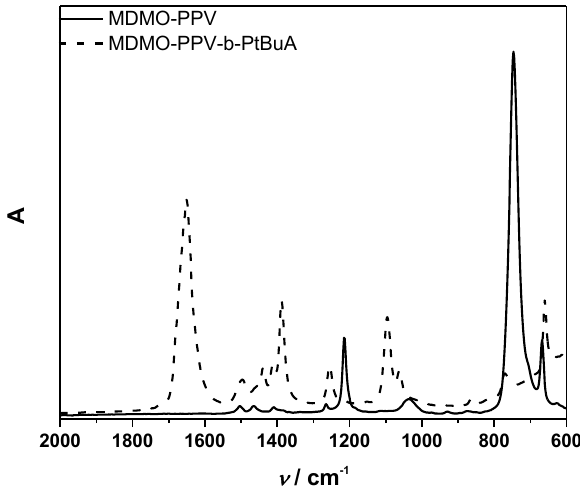
Figure A3. ATR FT-IR spectra for MDMO-PPV and MDMO-PPV- b -P t BuA.